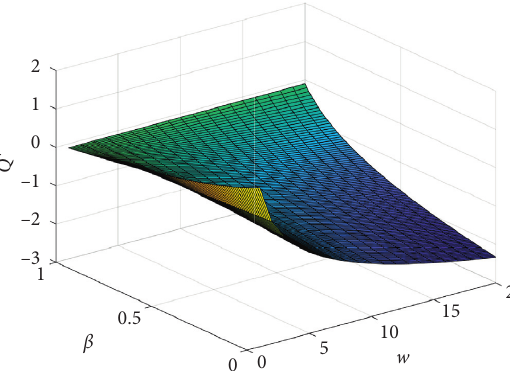
Figure 3: Effect of risk level β and retail price p on the optimal inventory quantity Q ∗ under RMI mode with stochastic demand in the water supply chain.